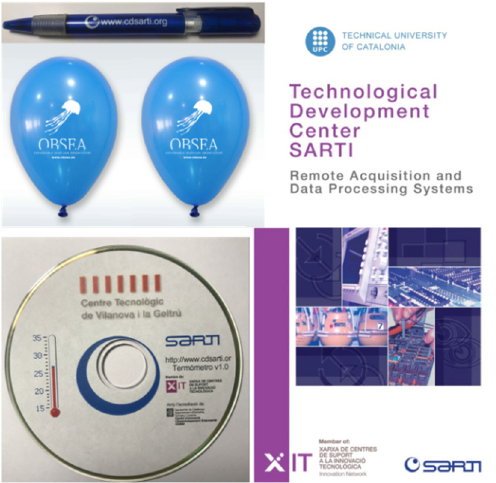
Figure 4. SARTI promotion and dissemination material.